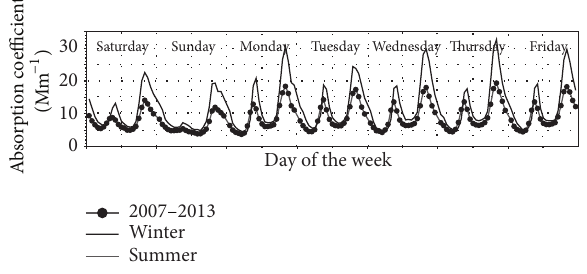
Figure 6: Average daily variations of the absorption coefficient, measured between 2007 and 2013, throughout the days of a week. Winter and summer seasonal values are also shown